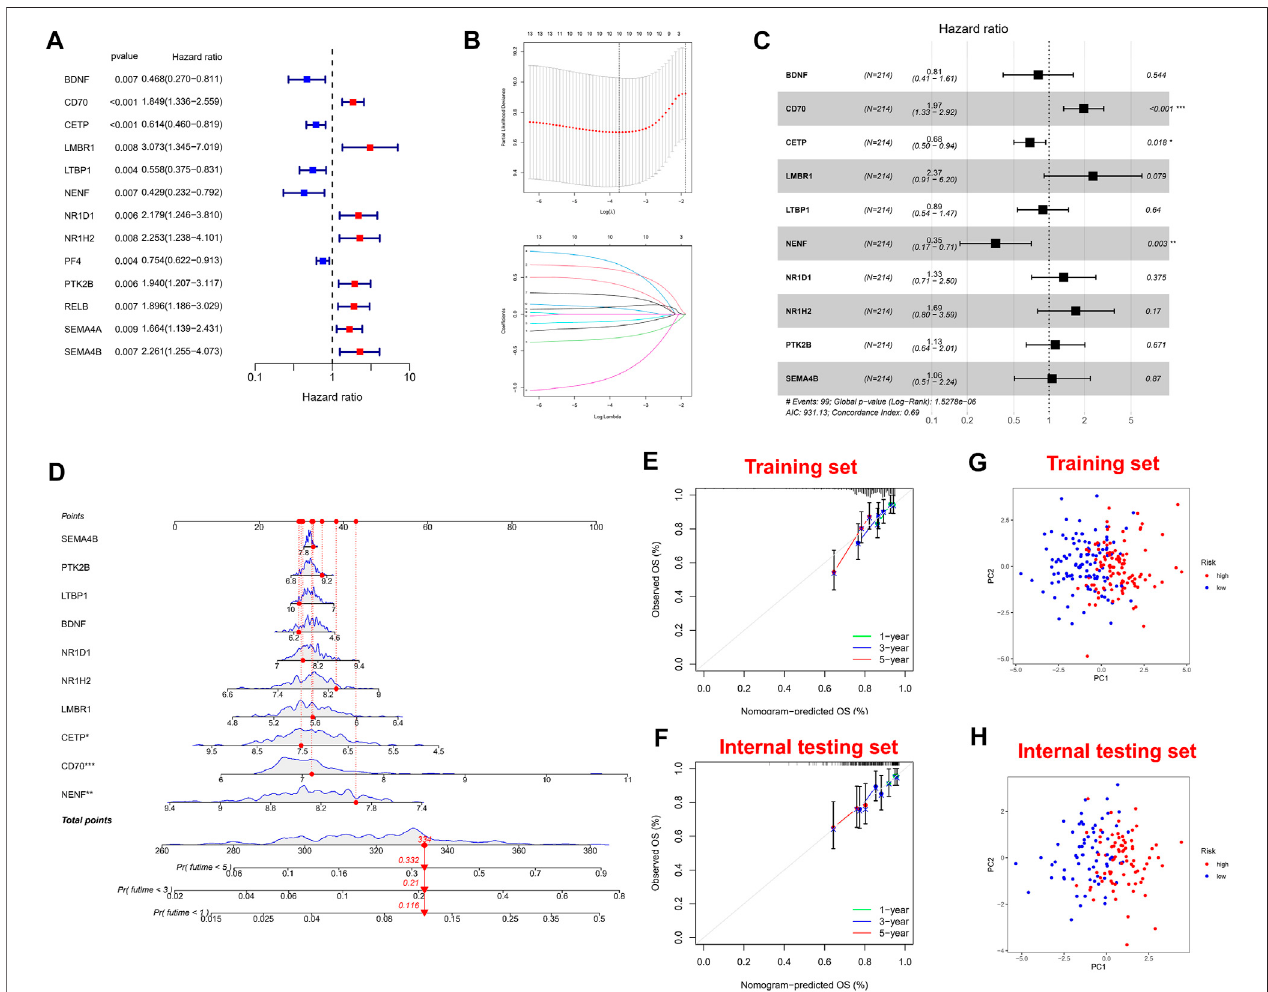
FIGURE4| Constructionandvalidationofimmune-relatedsignature. (A) Aforestofunivariatecoxregressionanalysisintrainingset. (B) LASSOregressionanalysis for most suitable λ . (C) Aforest ofmultivariate coxregressionanalysis. (D) Nomogram based on10-IRGs. (E) Calibrationcurve inthe training set. (F) Calibrationcurvein the internal testing set. (G) PCA plot in the training set. (H) PCA plot in the internal testing set. The red dots represent high-risk patients and blue dots represent low-risk patients.